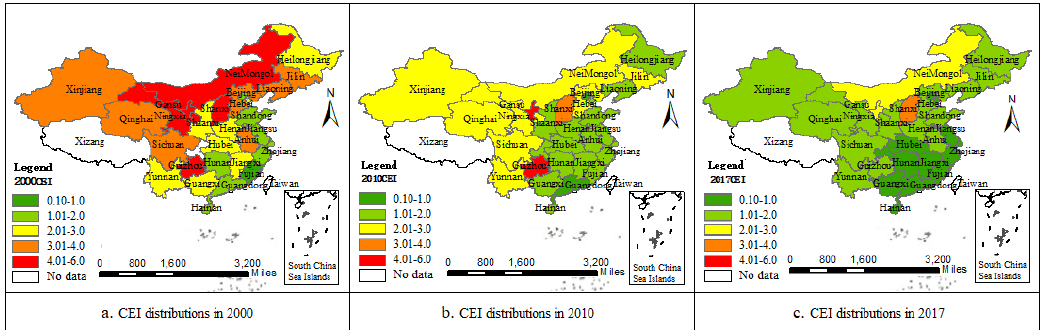
Figure 6. Spatial pattern of CEI in 2000, 2010 and 2017.